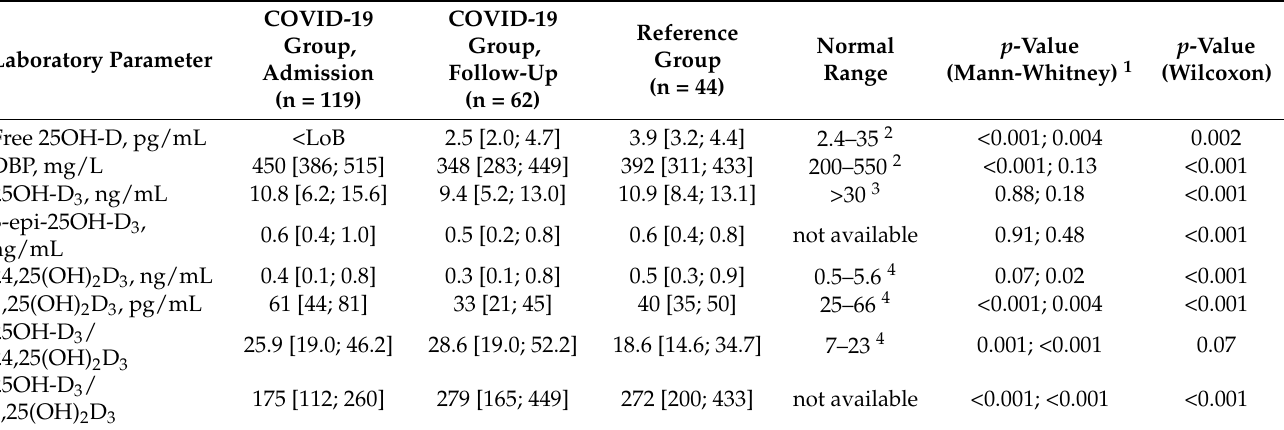
Table 4. Levels of free 25OH-D, vitamin D-binding protein (DBP), and vitamin D metabolites in COVID-19 patients and reference group.